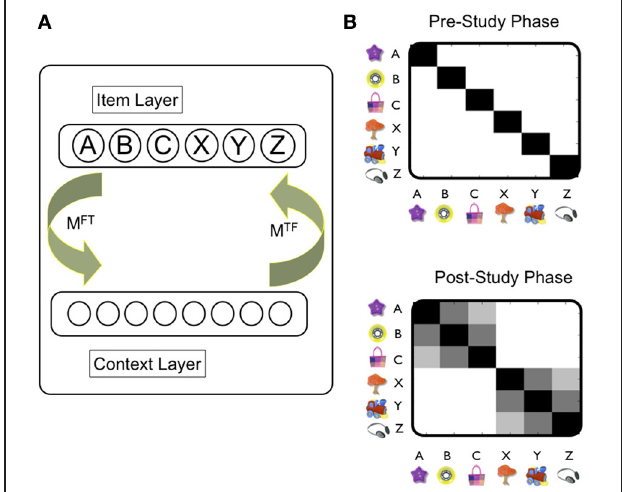
FIGURE 2 | Temporal Context Model (TCM): overview of operation and representations. (A) The TCM: Howard et al., 2005: there are two main layers (Item, Context). Training trials are presented as input to the item layer. M FT indicates connections between item and context layer. M TF indicates connections between context and item layer. Hebbian learning typically used to update these connections. See main text for details. (B) Similarity (i.e., overlap) of representations over the context layer induced by each object captures direct (e.g., A-B) and indirect associations (e.g., A—C). White shading indicates a value of zero, and black a value of one. Prior to the experiment, the contextual states activated by each objects are assumed to be orthogonal to each other—denoted by black shading only across the diagonal (upper figure). After the study phase, the contextual representations induced by objects in a triplet (A, B, C) have now become similar to each other—but not to objects in other triplets (e.g., X, Y, Z). Critically, this is the case for contextual representations associated with A and C objects [i.e., denoted by shading in [A, C] square: even though these objects were presented in different study pairs (i.e., AB, BC)]. It is worth noting that the similarity between objects presented in the same study pair (e.g., A, B) is greater than that between different pairs (i.e., A, C). Note that the similarity between different objects reflects the dot product between vectors specifying the contextual representation associated with each object. See Howard et al., 2005 for implementational details of the TCM